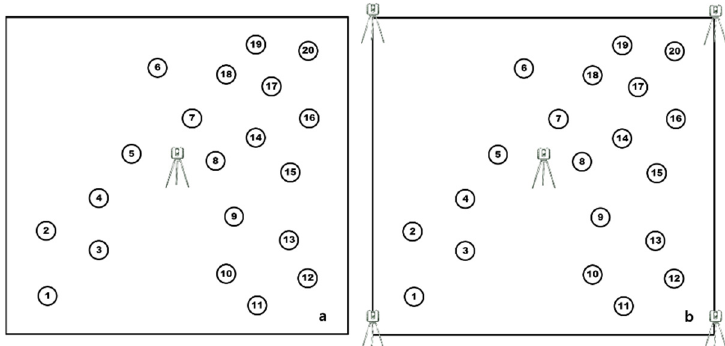
Figure 3. Data collection using TLS ( a ) single-scan and ( b ) multi-scan.